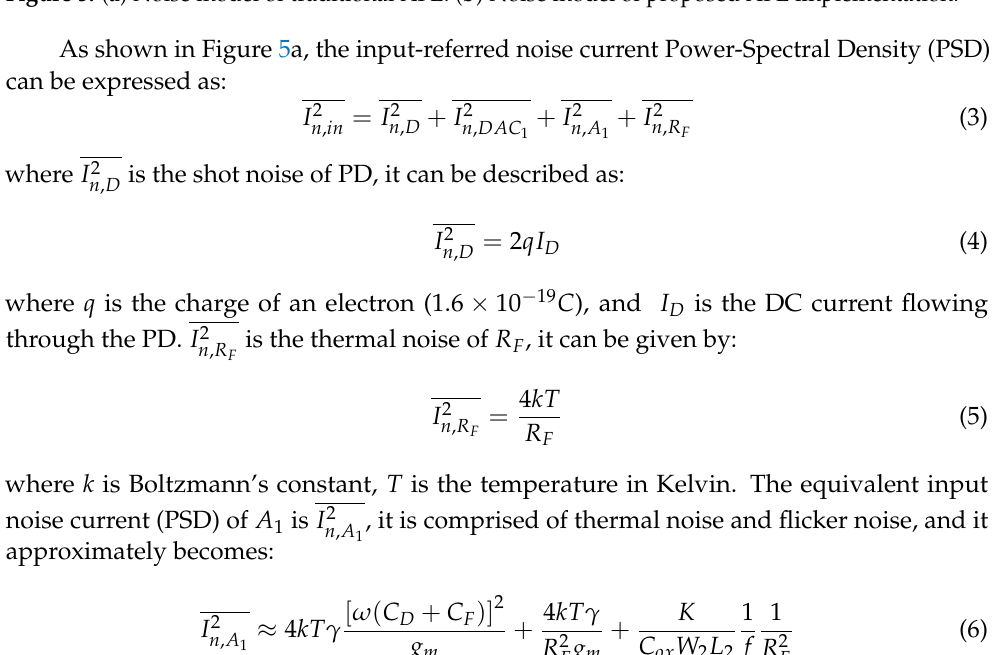
Figure 5. ( a ) Noise model of traditional AFE. ( b ) Noise model of proposed AFE